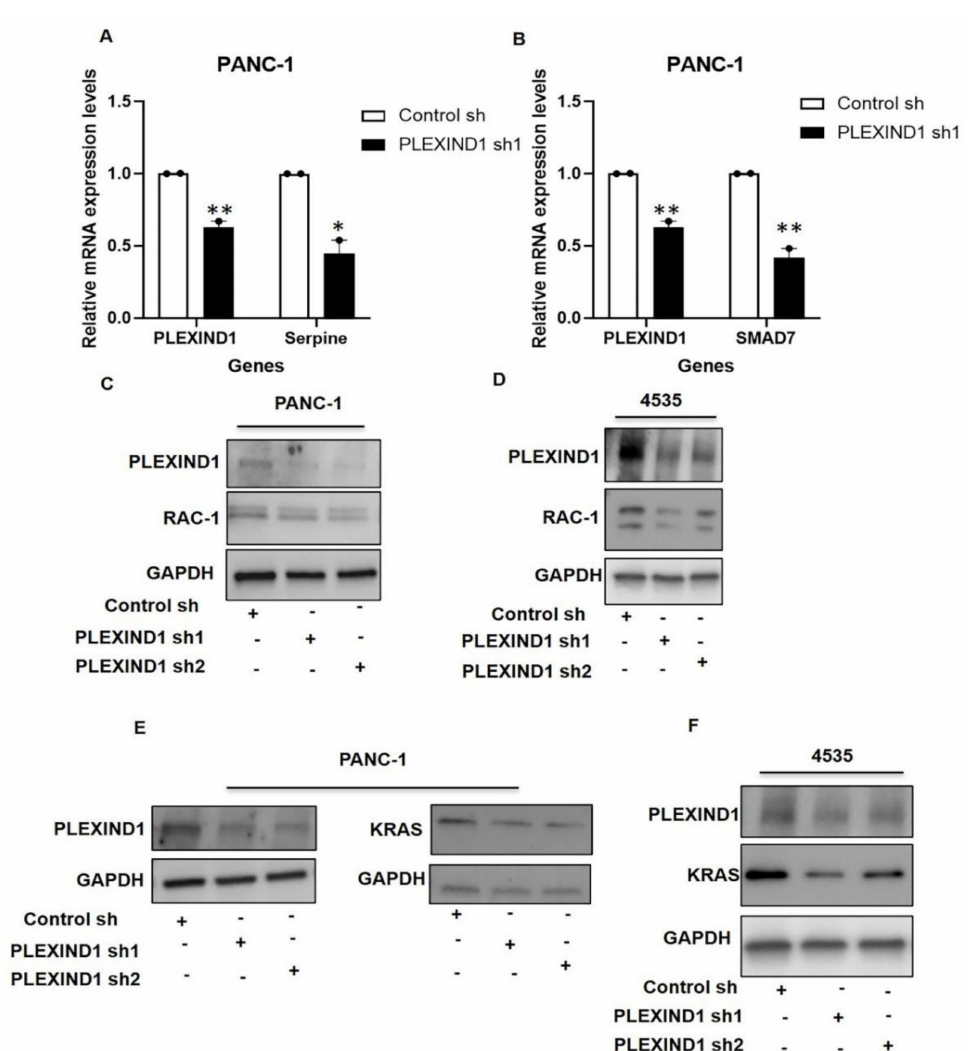
Figure 5. Decreased PLEXIND1 expression results in reduced RAC1 expression in PANC-1 cells. ( A , B ): Real-time quan- tifications of Serpine and SMAD7 expression in PANC-1 cell with PLEXIND1 knockdown. ( C , D ): Western blot analysis showing expression of RAC-1 in PANC-1 and 4535 cells with reduced PLEXIND1 levels. ( E , F ): Western blot evaluation of KRAS expression in PANC-1 and 4535 cells with PLEXIND1 knockdown. Statistical significance * p < 0.05 vs. control, ** p < 0.01 vs. control. Error bars represent standard error of the